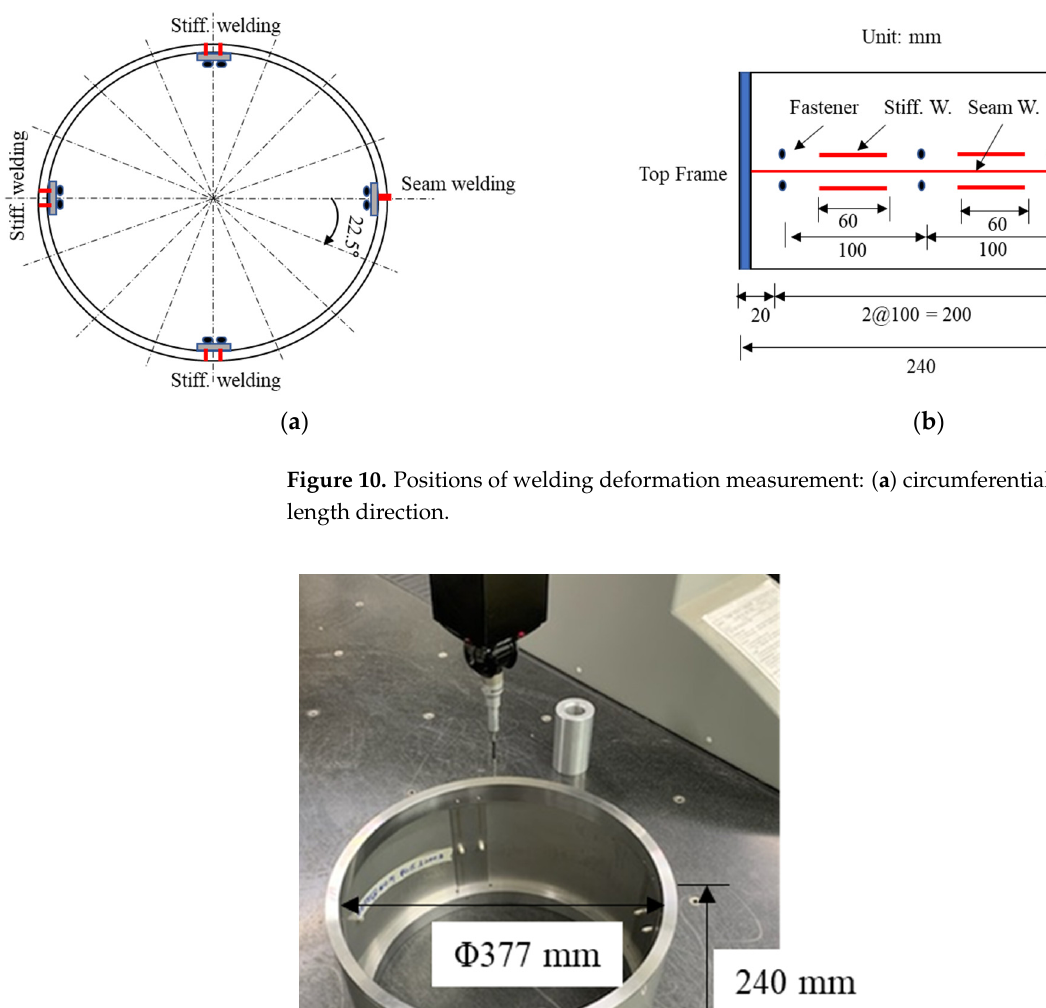
Figure 9. Picture of jig to give forced displacement: ( a ) full picture; ( b ) contact part of the jig. Figure 10 demonstrates the location for the deformation measurement in the cylin- der. The circumferential length was measured at intervals of 22.5° in a clockwise direction,